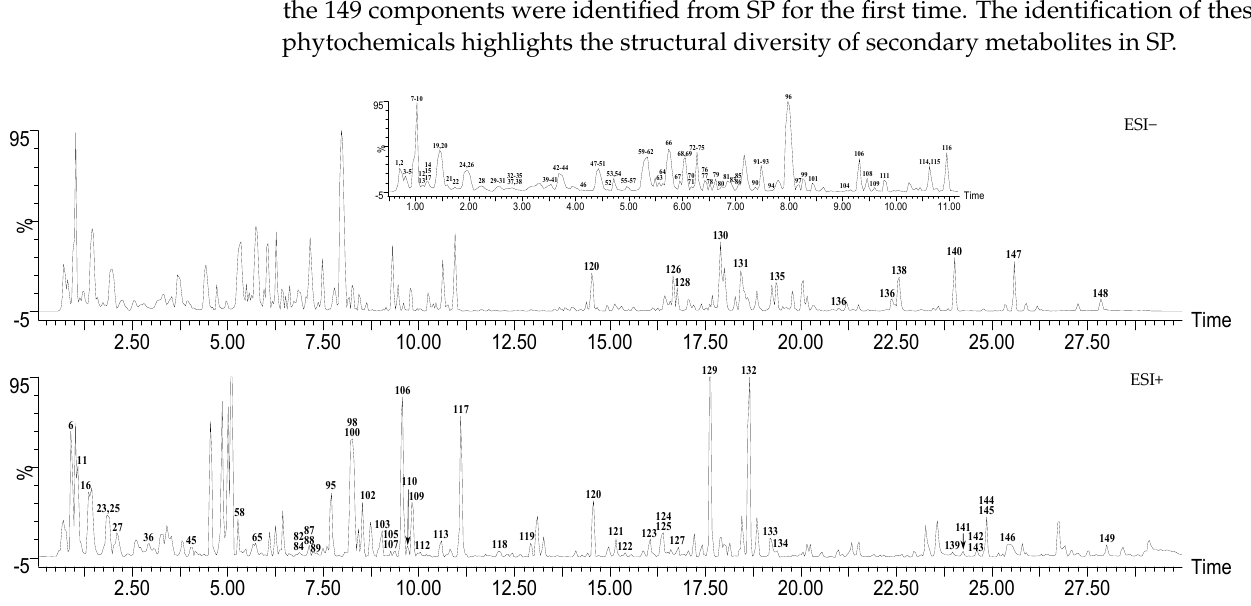
Figure 1. The base peak intensity (BPI) chromatograms of SP in ESI − and ESI+ modes.